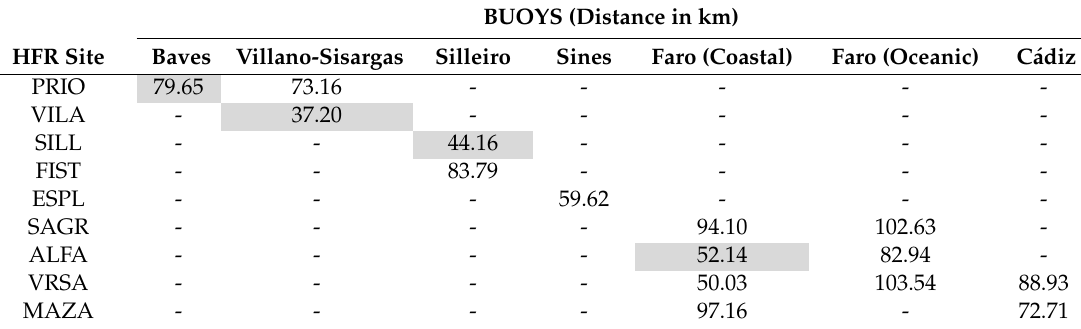
Table 3. Distance between HFR stations and buoys (km). Grey cells: HFR-buoy with wave data observation